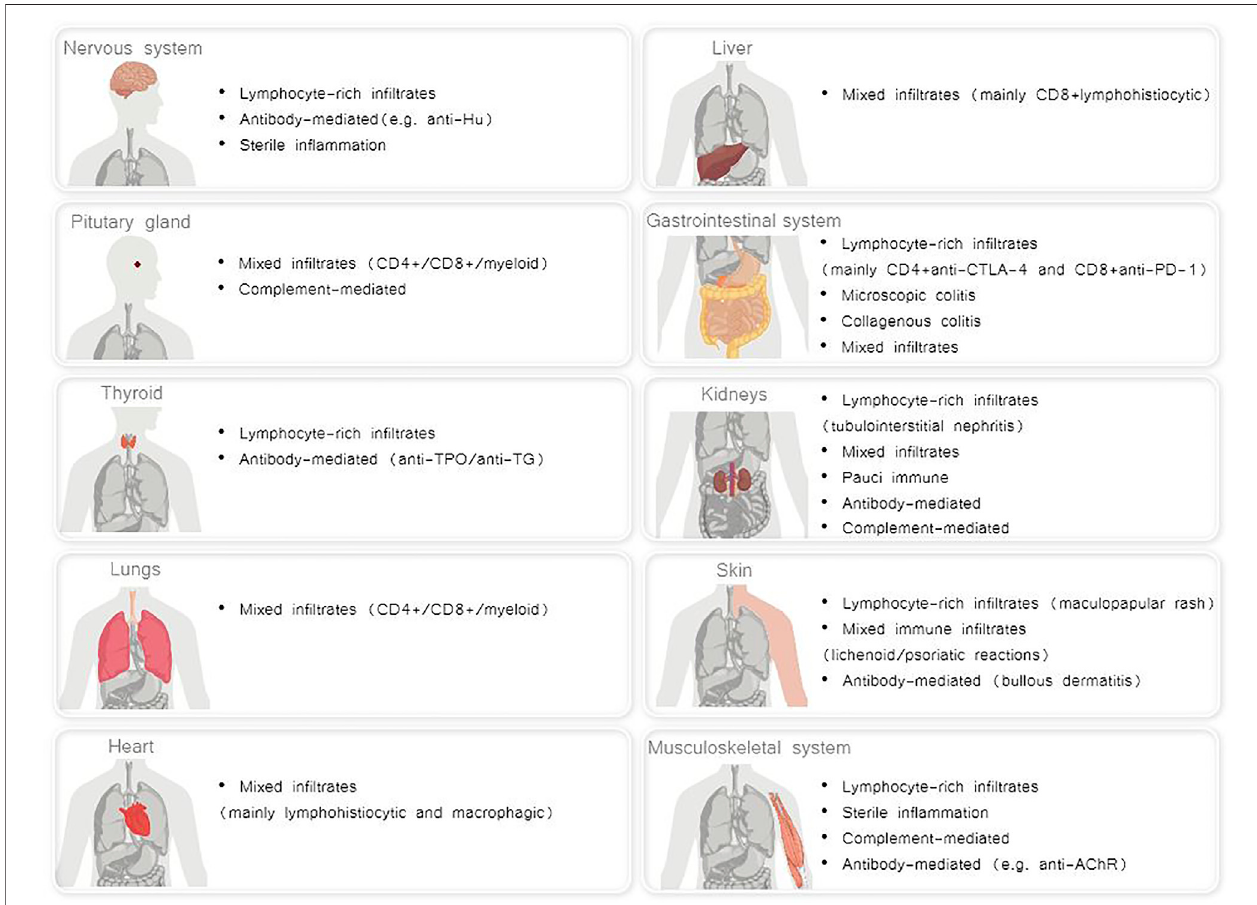
FIGURE 1 | Distinct histopathological phenotypes of irAEs per each affected organ (Albarel et al., 2019; Esfahani et al., 2020a; El Sabbagh et al., 2020; Khan and Gerber, 2020).